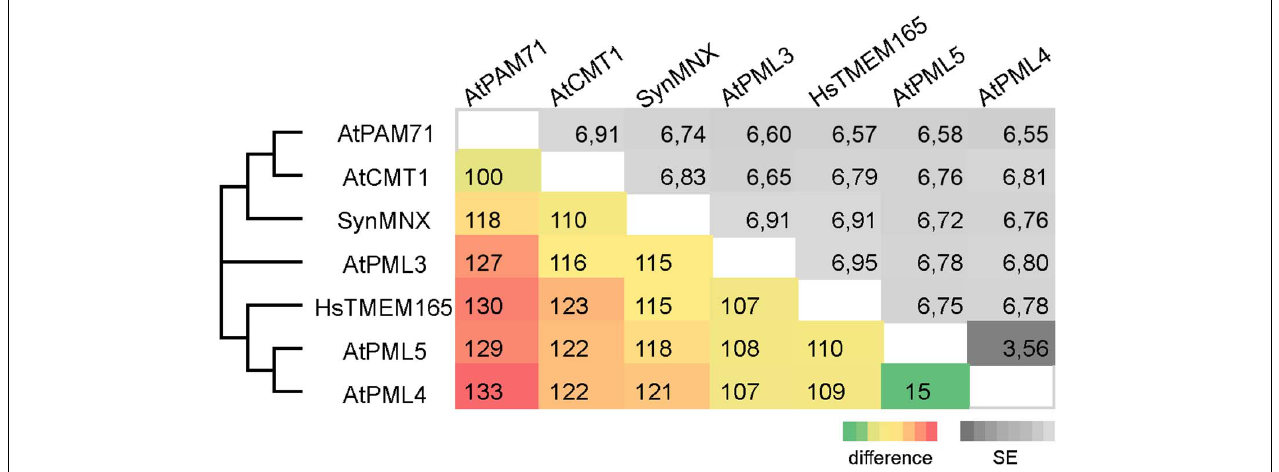
FIGURE 2 | Pairwise comparison of UPF0016 members of Arabidopsis, Synechocystis and human. The numbers of amino-acid differences between the indicated sequences are shown. Standard-error (SE) estimates are shown above the diagonal and were obtained by a bootstrap procedure (1,000 replicates). The consensus tree in which the associated proteins clustered together is indicated on the